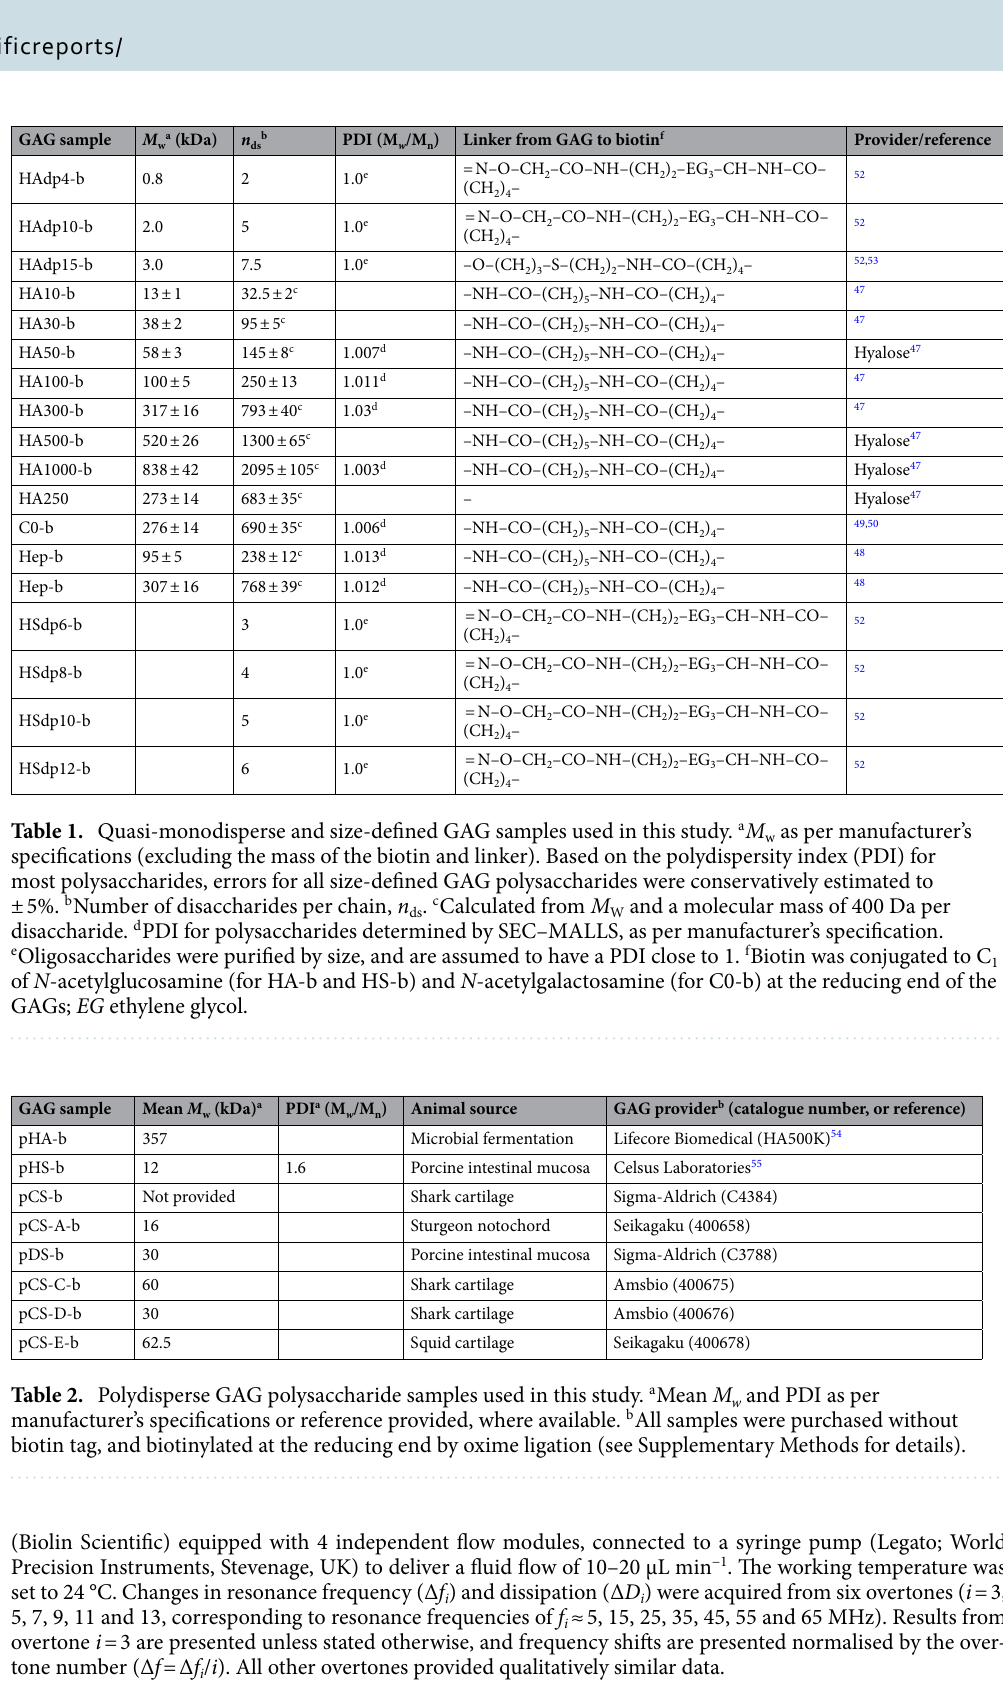
for size-defined samples, 3 µg for polydisperse samples) was mixed with FACE loading agent (a mixture of glycerol and uH 2 O at a ratio of 1:3 v / v , and 1 mg mL −1 bromophenol blue) and 1× Tris–borate buffer (0.05 M Trizma base, 0.06 M boric acid, pH 8.3) at volumes of 10 µL, 3 µL and 2 µL, respectively. GAG polysaccharides of